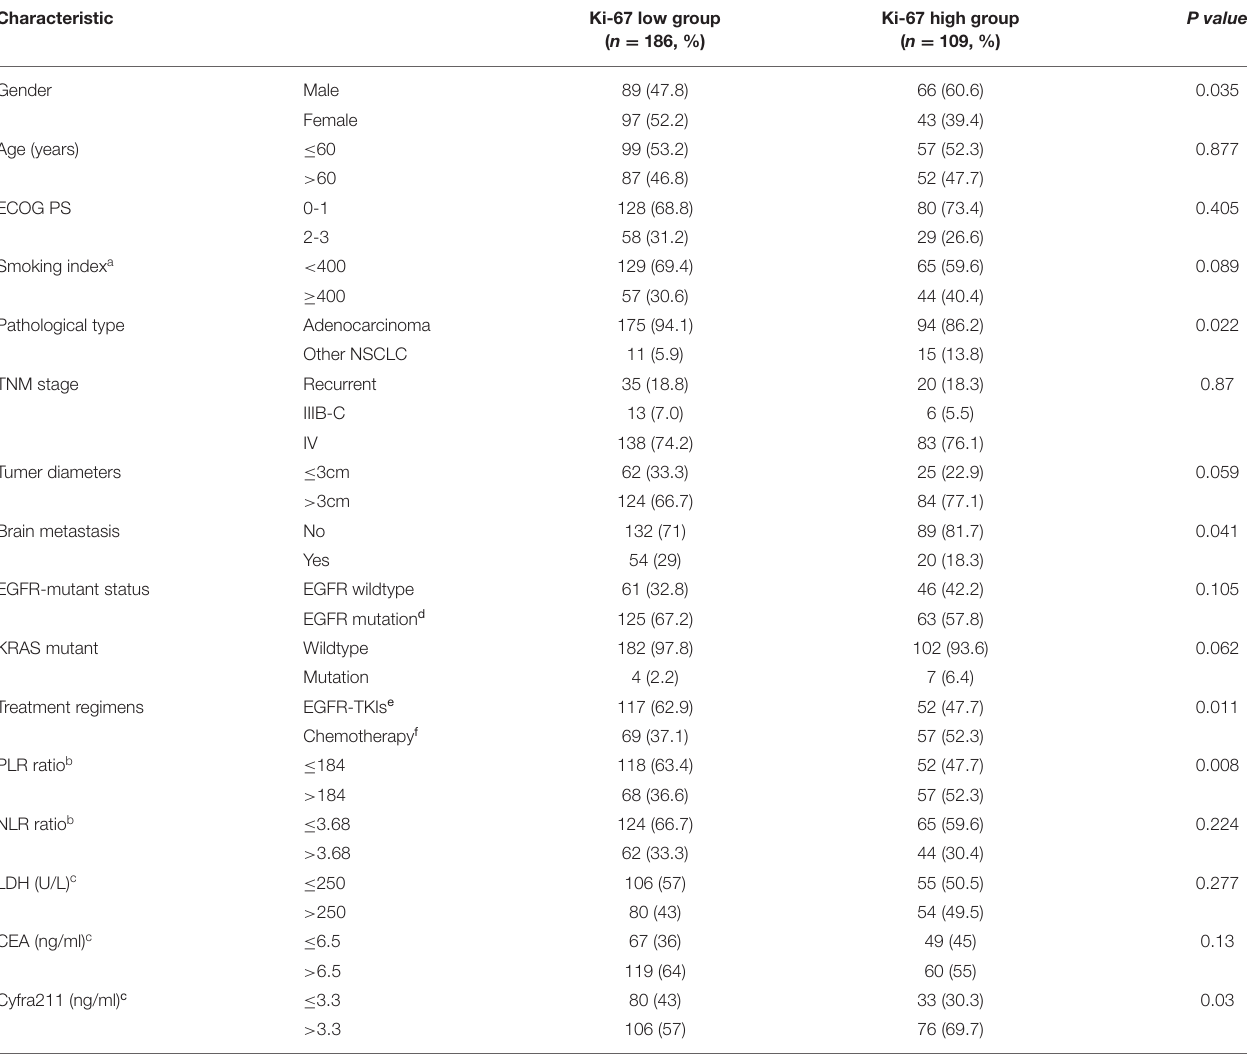
TABLE 1 | Characteristics of 295 patients received first-line therapy in NSCLC with EGFR mutation status. Characteristic